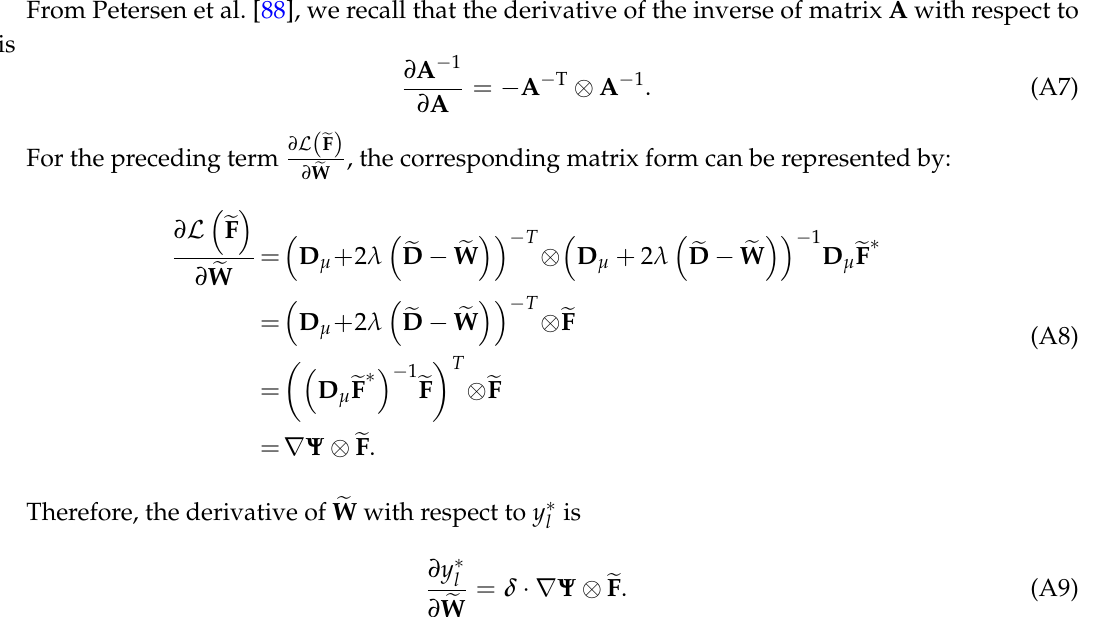
Table A1b. The scale is implicitly expressed in the pooling layer by factor 2.0.